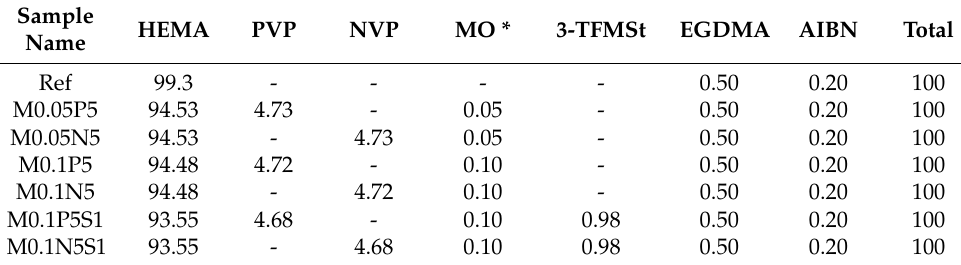
Table 1. Percent composition of samples (unit: